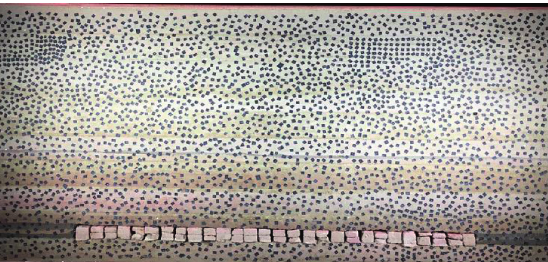
Figure 11: Movement characteristics of overburden strata at an advance of 140m in the filling face.